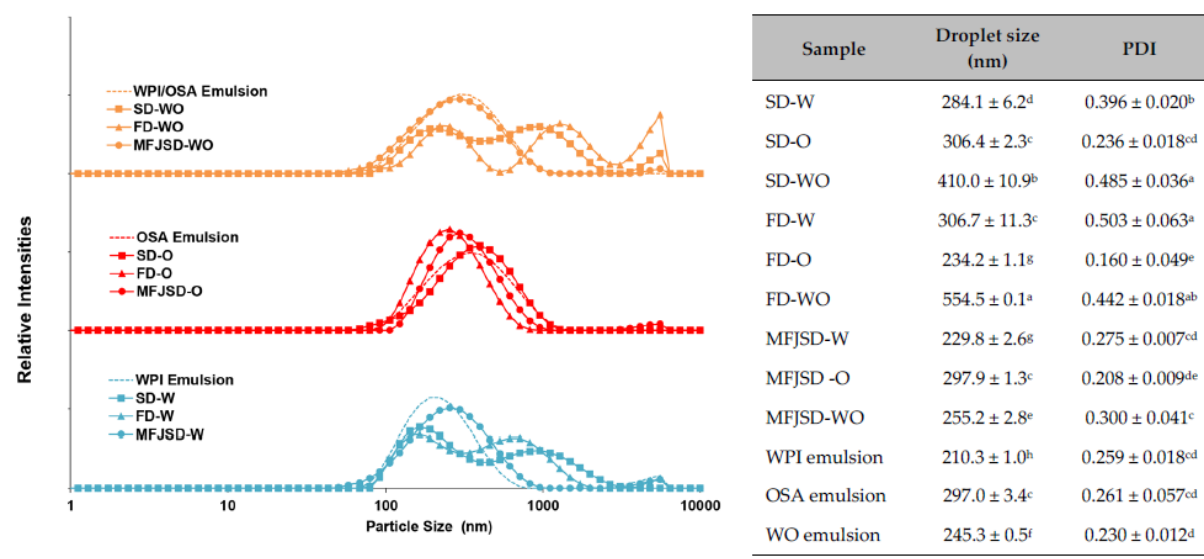
Figure 3. Particle size distribution of the initial and reconstituted emulsions. SD-W, SD-O, and SD-WO: microcapsules produced by two-fluid nozzle spray drying, using WPI only, OSA only, and a combination of WPI/OSA (50/50 w/w ) as wall materials, respectively; FD-W, FD-O, and FD-WO: microcapsules produced by freeze-drying, using WPI only, OSA only, and a combination of WPI/OSA (50/50 w/w ) as wall materials, respectively; MFJSD-W, MFJSD-O, and MFJSD-WO: microcapsules produced by microfluidic-jet spray drying, using WPI only, OSA only, and a combination of WPI/OSA (50/50 w/w ) as wall materials, respectively. WPI: whey protein isolate; OSA: octenylsuccinic anhydride modified starch. WO: a combination of WPI and OSA (50/50 w/w ). PDI: particle size distribution index. Different letters in superscript for each column indicate significant differences at p < 0.05.